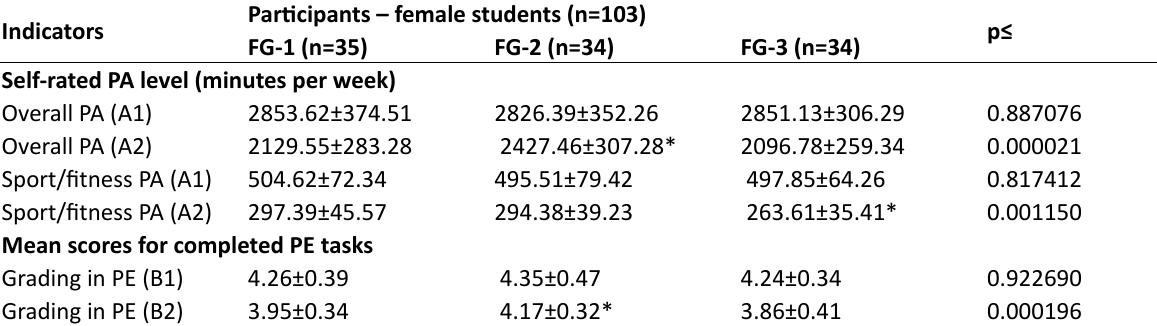
Table 2. Mean PA rates and grading in PE pre- and post-cancellation of face-to-face PE classes for female participants.